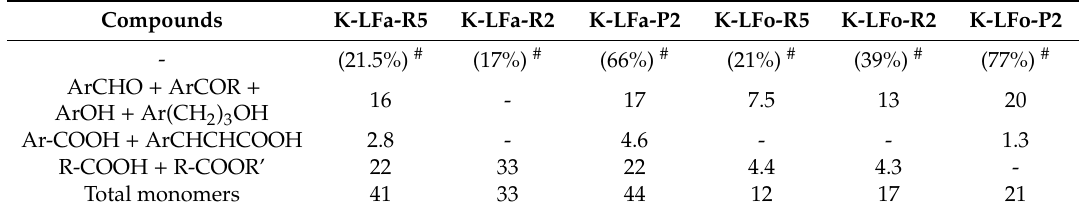
Table 4. Summary of the GC / MS results of fractions coming from aqueous and organic processes applied on K-LF-0 illustrating the estimated amount of volatile compounds, divided in three main groups. Data reported as the total mass of compounds / mass of initial fraction (%). Values were rounded up to the nearest two significant figures with an estimated relative error of ±